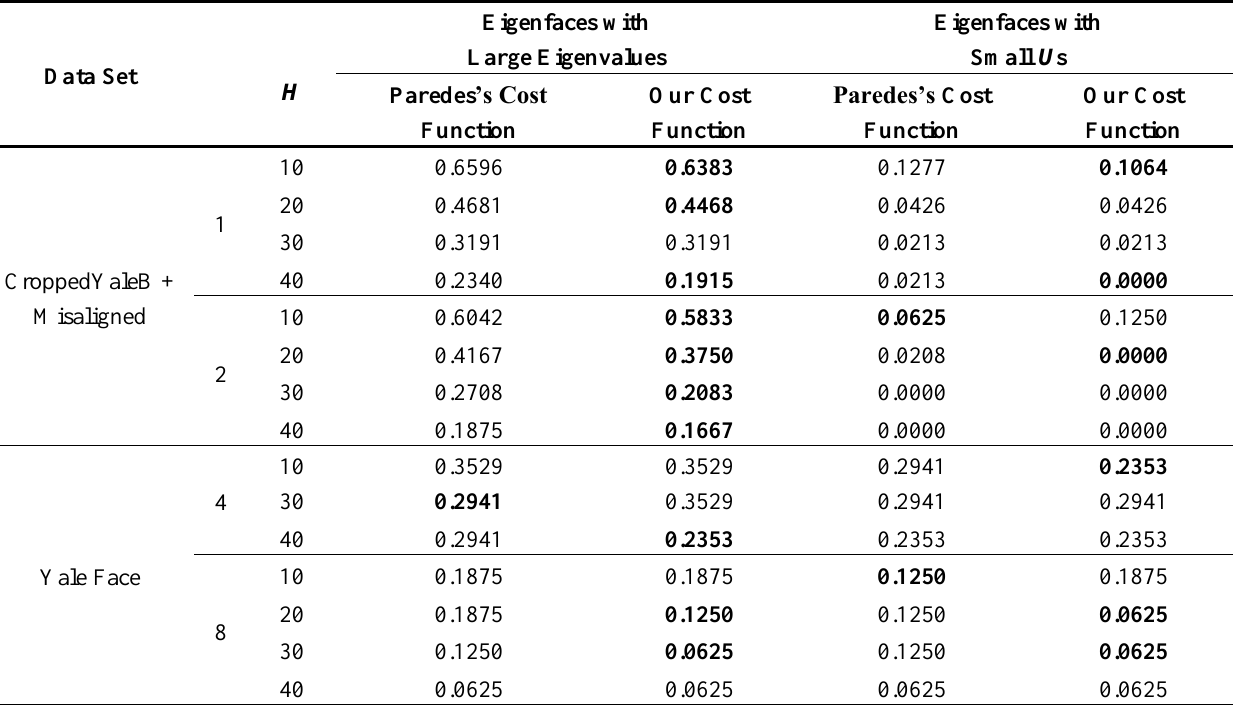
Table 2. Comparison of Paredes method and proposed RR-based method ( ε = 1.0 e −6, β = 10, k = 100).